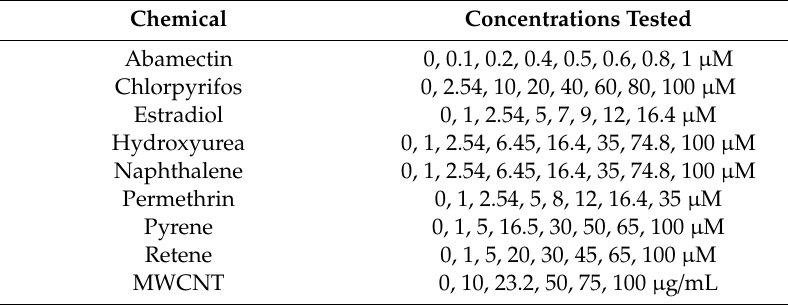
Table 2. Definitive bioactivity testing concentrations for each test agent.